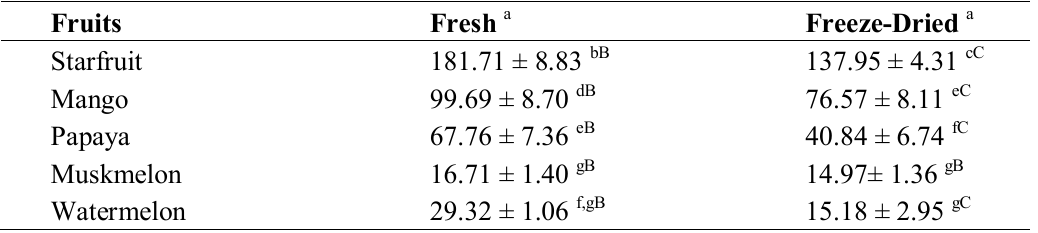
Table 2. Total phenolic compounds of fresh and freeze-dried fruits.